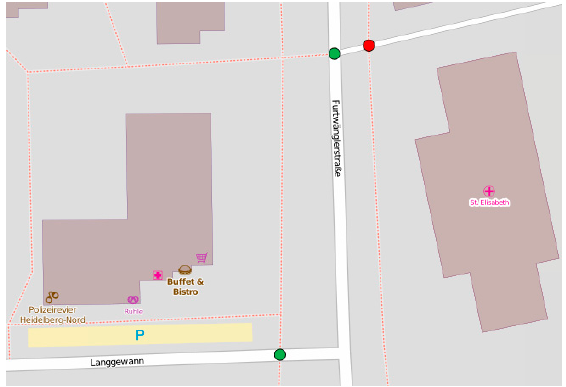
Figure 6. Query results identifying the entry points of footways. Identified entry points (in green) and discarded intersection points (in red).